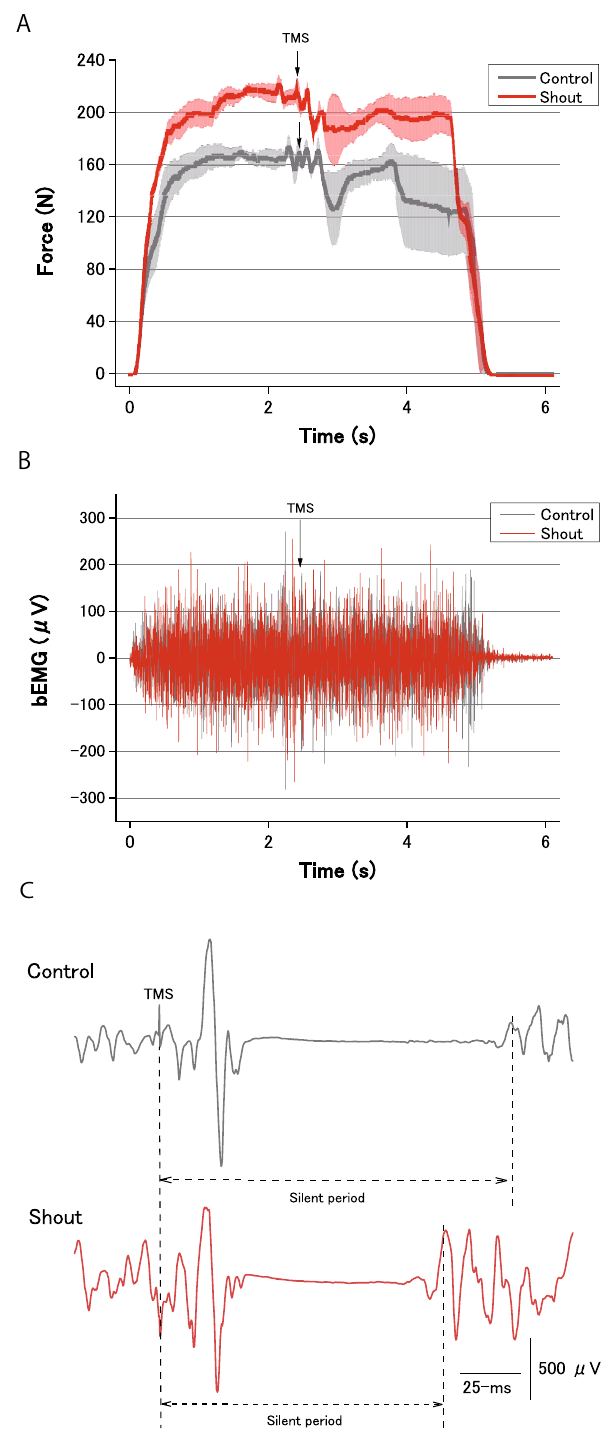
Figure 2. Typical recordings of handgrip force, background electromyography (bEMG), and typical motor evoked potential (MEP) waveforms of the flexor carpi ulnaris during the maximal voluntary contraction force (MVC) of handgrip in each experimental condition (control or shout) in a single participant. The timing of transcranial magnetic stimulation is indicated by the arrow. The handgrip force declined when transcranial magnetic stimulation was delivered during the contraction, the timing of which was different in each contraction. (A) Data of force are expressed as the mean ± standard error of the mean of five recordings. (B) bEMG during handgrip contraction for each condition. (C) Duration of the cortical silent period during handgrip contraction for each